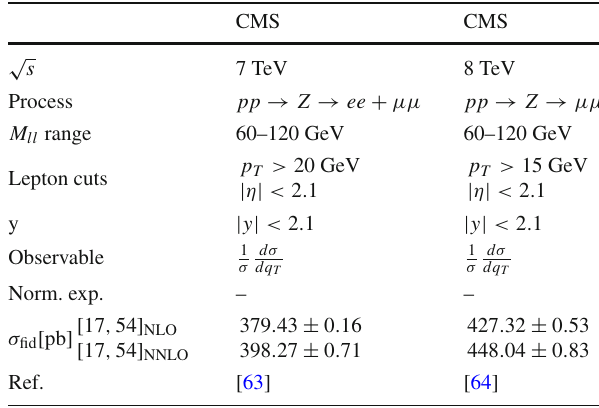
Table 7 The characteristics of the Z-boson production data measured by CMS